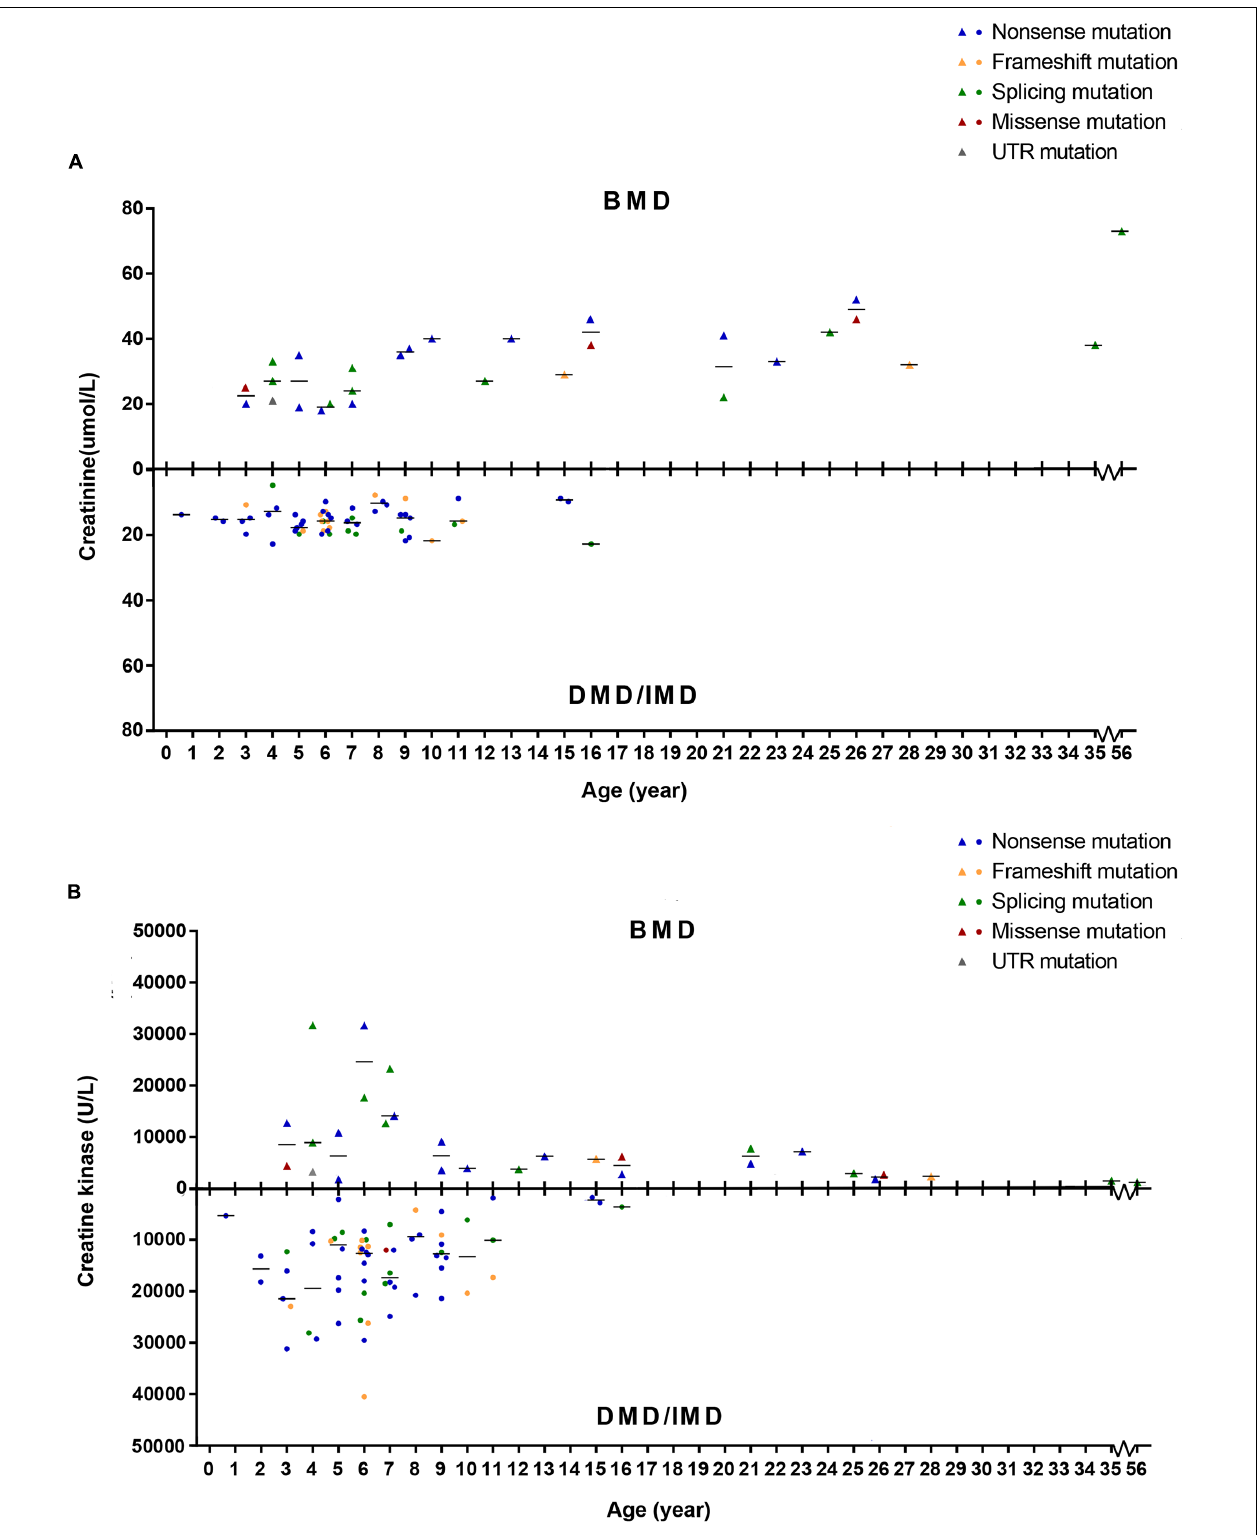
FIGURE 8 | Correlations between phenotypes and serum creatinine (SCRN) or creatine kinase (CK) levels. (A) SCRN levels in patients with Duchenne muscular dystrophy (DMD)/intermediate muscular dystrophy (IMD) or Becker muscular dystrophy (BMD). (B) CK levels in patients with DMD/IMD or BMD. The median of SCRN levels at each age is represented by short